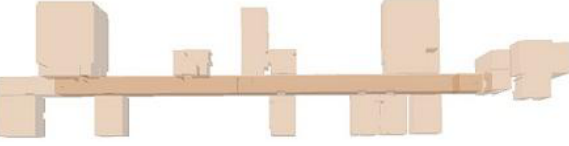
Figure 2. The 3D building model before subspacing based on connected opening spaces (from top